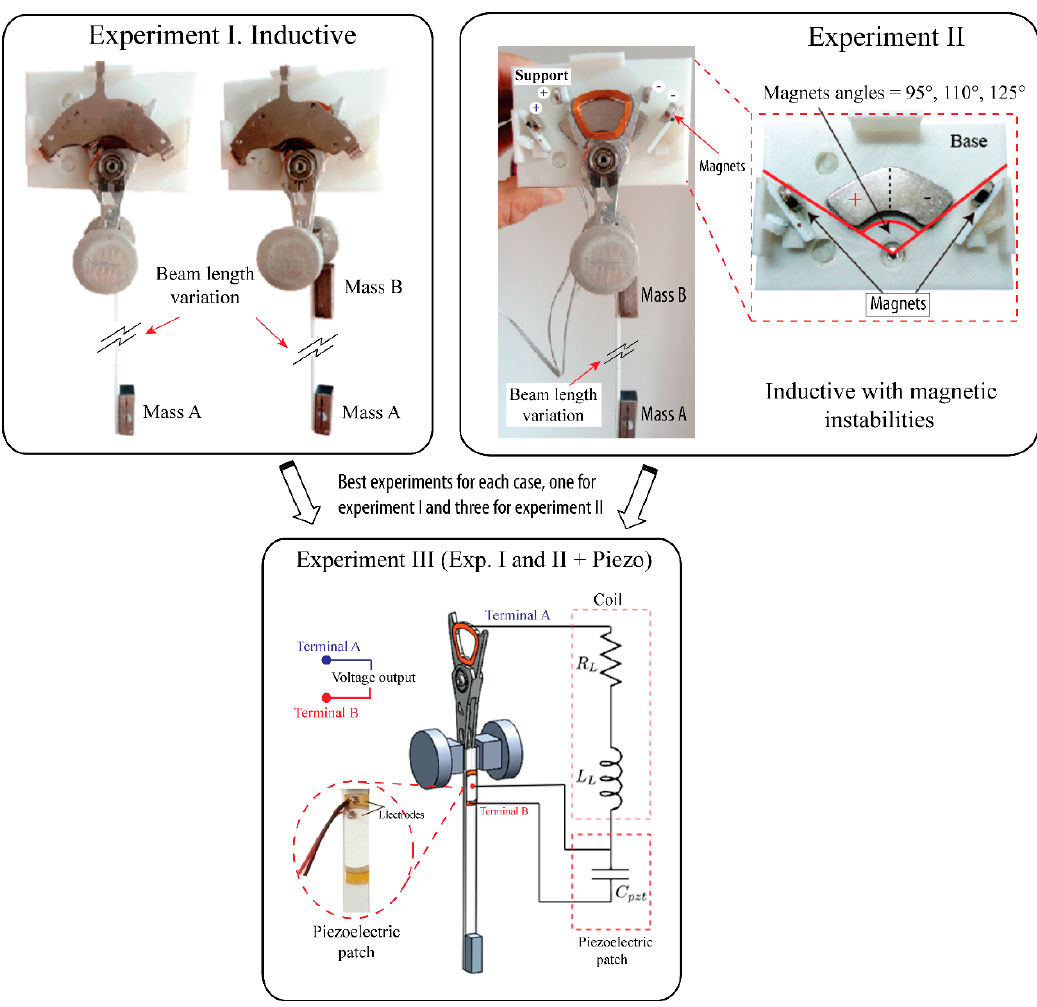
Figure 4. Experimental methodology composed by: Experiment I with an I-VEH; experiment II with an IM-VEH, and experiment II with a PI-VEH.